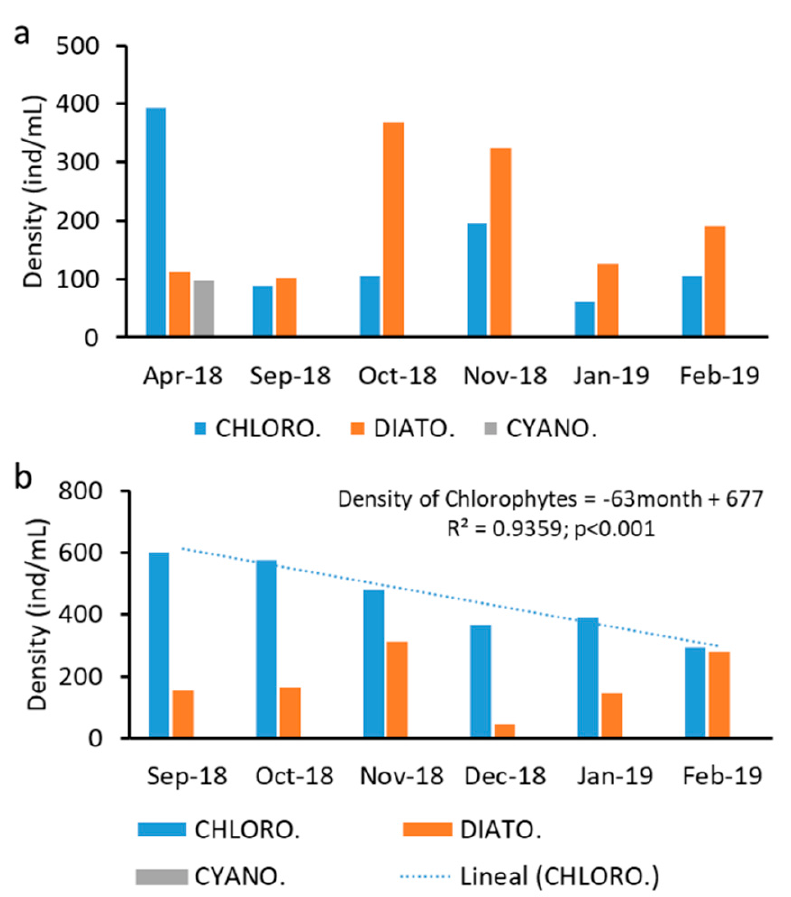
Figure 6. Density averages of MIC main groups in each sampling site from ( a ) Estero del Padre Ramos and ( b ) Estero Salinas Grandes. Values of means and their standard deviation are given in Table S3 (Supplementary